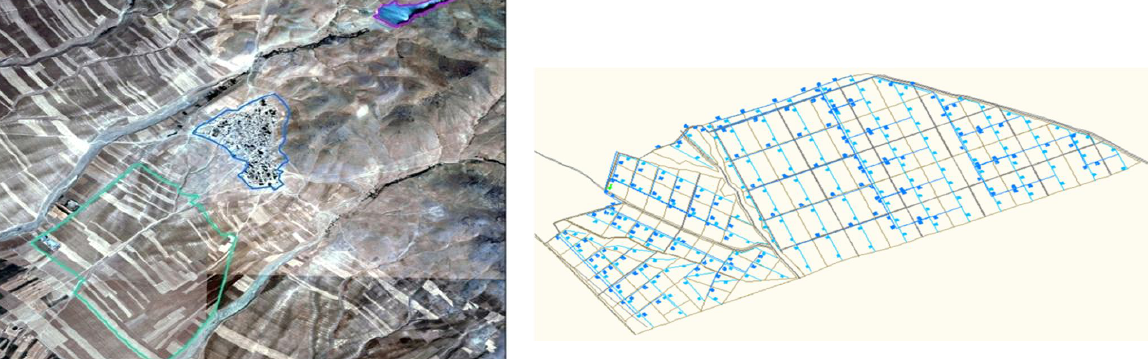
Fig. 1. Satellite photo of Cadastral maps Boein coastal dams before integration and the development of agriculture